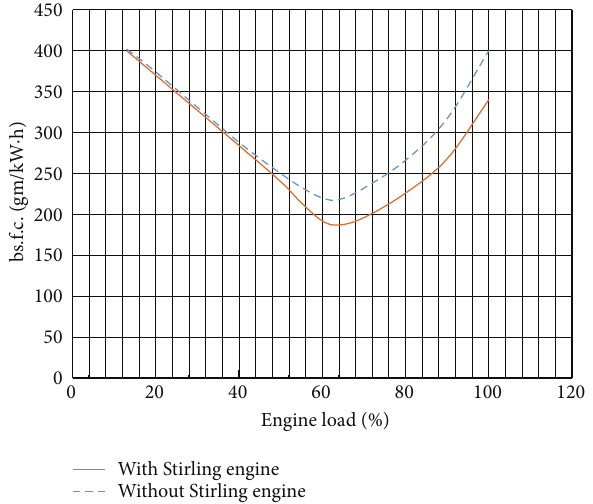
Figure 11: Showing brake specific fuel consumption without Stirling engine and with Stirling engine.